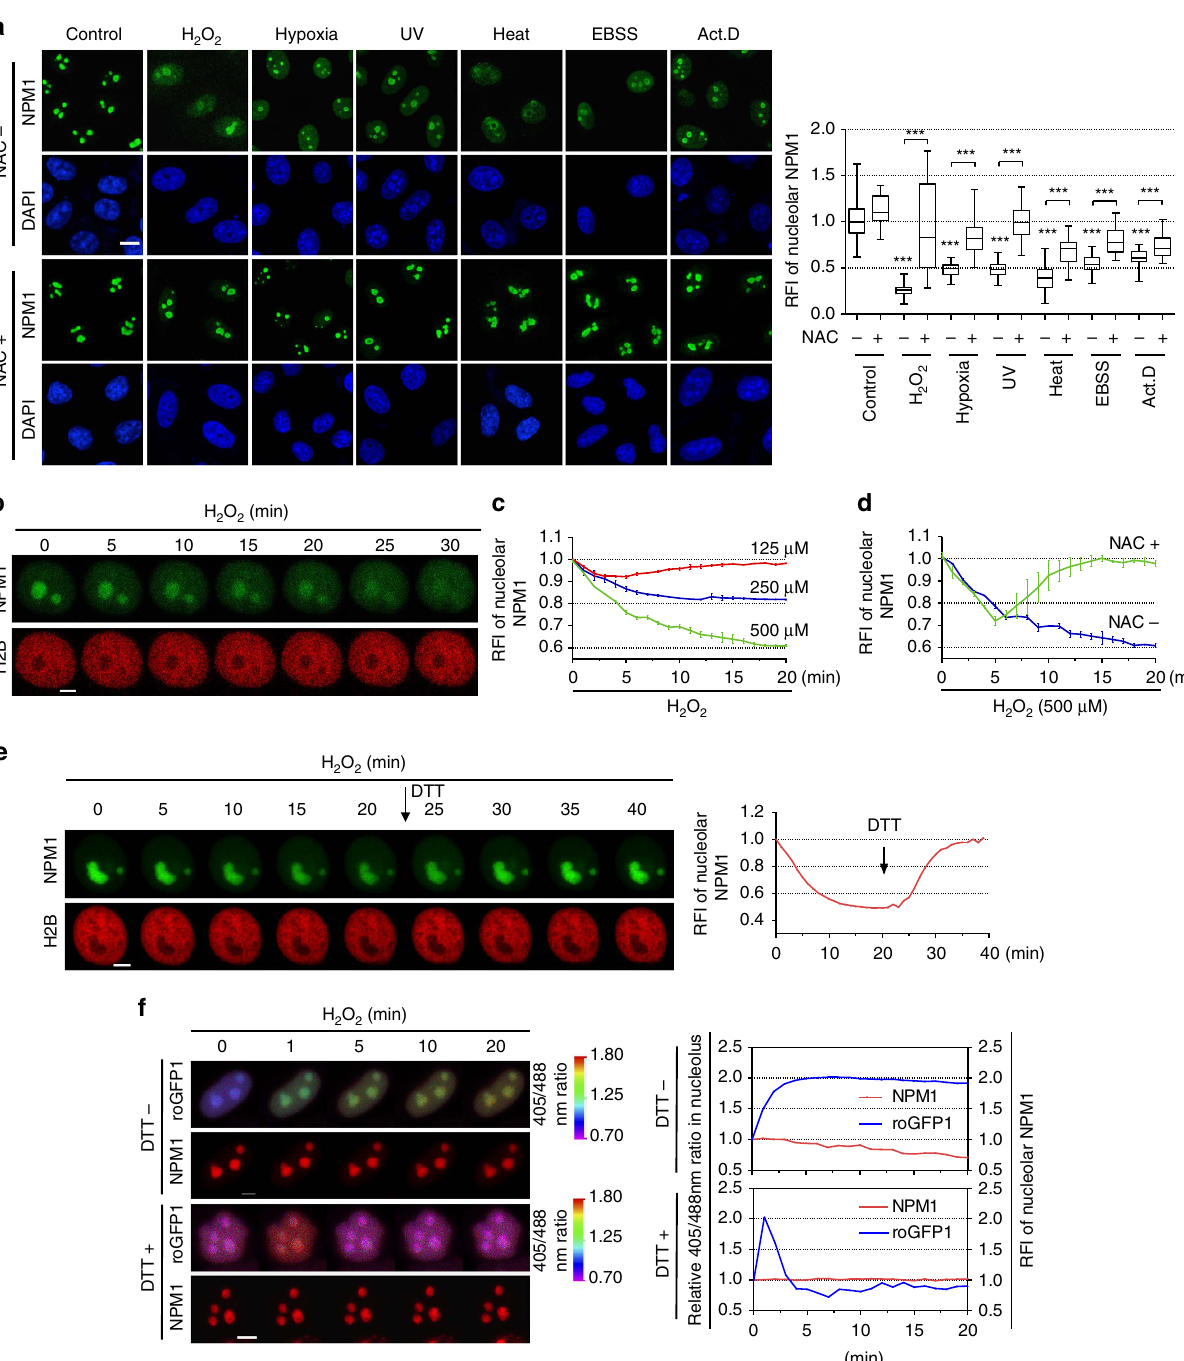
Figure 2 | NPM1 translocation is elicited by nucleolar oxidation. ( a ) Endogenous NPM1 translocation under various cellular stresses ± NAC pretreatment (as in Fig. 1b). Representative images (left) and the RFI of the nucleolar NPM1 (right) were displayed. n ¼ 55 cells. Unpaired t -test, *** P o 0.001 with respect to treated versus untreated or (cid:2) NAC versus þ NAC cells. The nucleolar and nucleoplasmic line profiles of NPM1 were analysed in Supplementary Fig. 2a. ( b ) EGFP-NPM1 translocation upon H 2 O 2 (500 m M) exposure, visualized by live-cell imaging. Representative images at indicated times were displayed. ( c , d ) RFI changes of nucleolar EGFP-NPM1 per minute upon three doses of H 2 O 2 treatments or H 2 O 2 (500 m M) plus pretreatment of NAC. ( e ) EGFP-NPM1 translocation upon H 2 O 2 (500 m M) exposure followed by the addition of 5mM DTT after 20min. ( f ) EGFP-NPM1 translocation and nucleolar redox changes upon H 2 O 2 (500 m M) exposure ± DTT pretreatment in the same cells. Concurrent changes of relative 405/488nm ratio values reflecting redox state (left y axis) and RFI of nucleolar EGFP-NPM1 (right y axis) per minute were plotted. Scale bars, 10 m m ( a ) and 5 m m ( b , e , f) . Data were represented as mean ± s.e.m. indicated a slight transient oxidation of the nucleolus (Fig. 2f). redox states of the two compartments, and that its nucleo- These data confirmed that the shuttling of NPM1 between plasmic translocation following stress is elicited by nucleolar the nucleolus and nucleoplasm might be controlled by the oxidation. NATURE COMMUNICATIONS|7:13599|DOI: